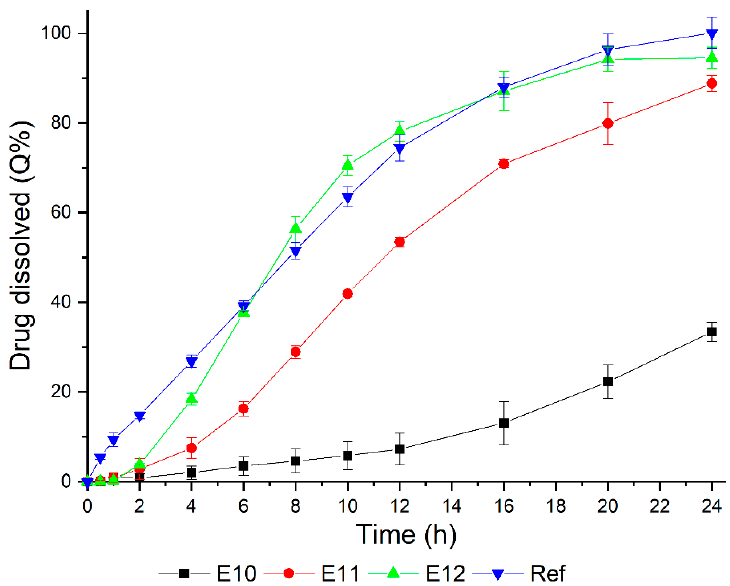
Figure 5. Coated mini-tablet formulations obtained in the optimization step and reference drug product (Selopress Zok ® ) dissolution profiles, evaluated using 900 mL of phosphate buffer at pH 6.8, paddle + sinker, and a 100 rpm rotation speed. Table 6. Percentage of drug dissolved (Q) and dissolution efficiency (DE%) of the MS, obtained for the additional formulations and its reference, Selopress Zok ® . The values for percentage of drug dissolved of the mini-tablets are expressed by the average of three determinations, and for the ref- erence drug product by the average of 12 units.